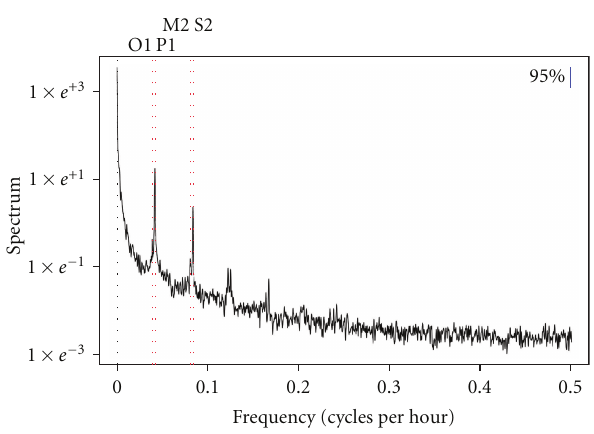
Figure 4: Fourier transform scaled periodogram of two years of temperature data at one monitoring site. Principal frequencies are marked with vertical, dashed lines and correspond to (from left to right) seasonal (365 days), lunar (O1, 25.82 hours), solar (P1, 24 hours), lunar semidiurnal (M2, 12.42 hours), and solar semidiurnal (S2, 12 hours). Other peaks between 0.1 and 0.2 cycles per hour are likely echoes of O1 and P1. Scale bar in the upper right corner is the 95% confidence